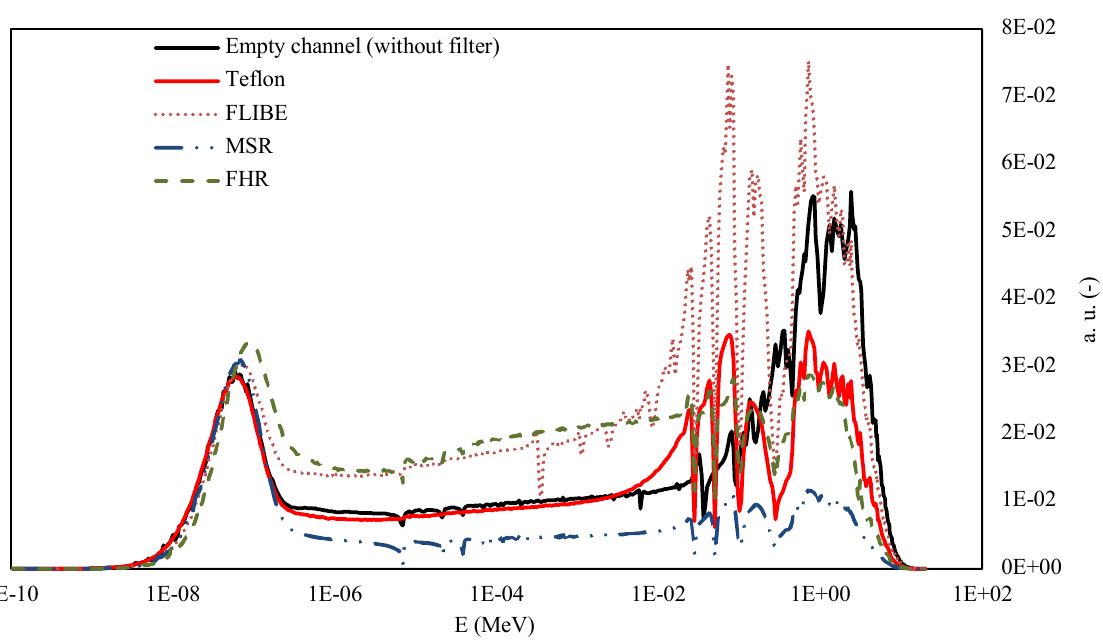
Figure 4. Comparison of the calculated neutron spectra in the LR-0 reactor with different insertions and reactor concepts using the fluoride molten salt. Table I. Ratios of the group fluxes for different calculation models . Empty ch.